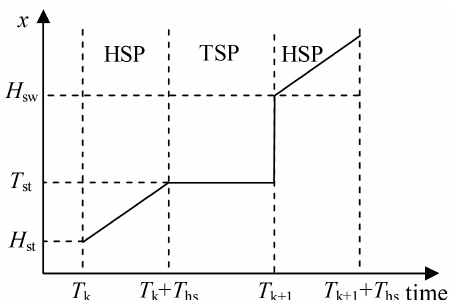
Figure 6. The reference Zero Moment Point (ZMP) trajectory of the biped robot. In the heel support phase, the ZMP moves from the heel to the toe of the stance foot. In the toe support phase, the ZMP is kept constant at the tiptoe. In the impact phase, the ZMP transfers from the tiptoe of the stance foot to the heel of the swing foot.